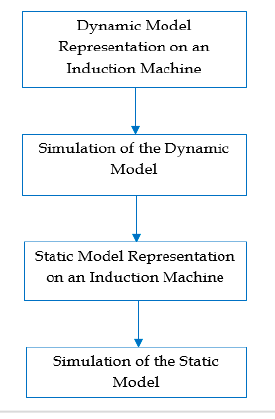
Figure 5. A proposed dynamic model of an induction motor.